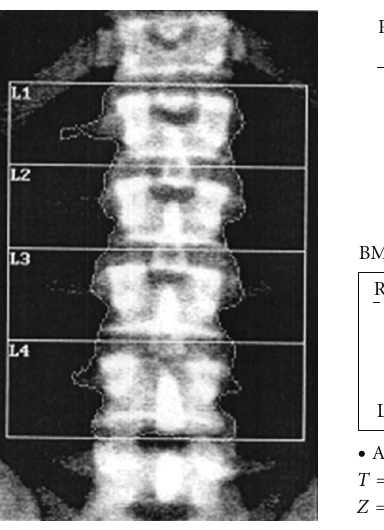
Figure 1: Bone mineral density (BMD) of the lumbar spine. Our patient presented with elevated bone mineral density at the lumbar spine (1.842g/cm 2 ). This value is 5.85 standard deviations above the mean for age- and sex-matched controls ( Z -score); 5.85 standard deviations above the mean level of peak bone mass ( T